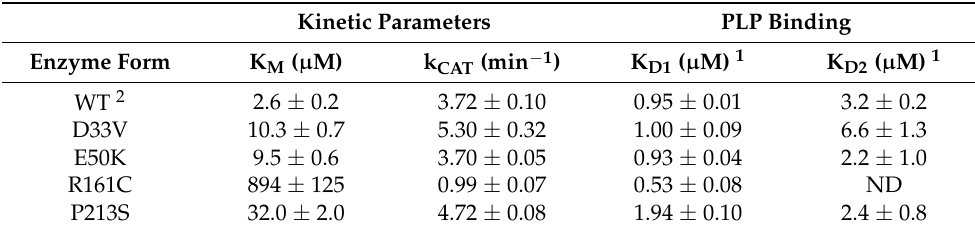
Table 1. Parameters obtained from kinetic and equilibrium measurements of PNPO variants using PNP as a substrate and PLP as an allosteric effector.